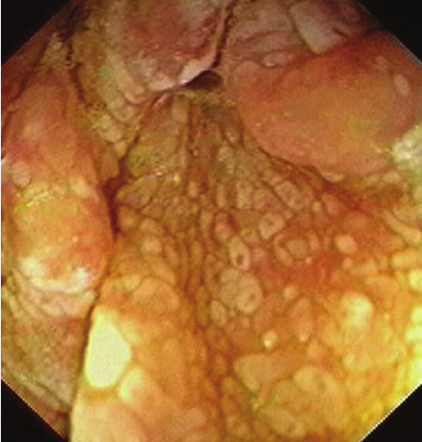
Figure 6: Whipple’s disease: endoscopic view of the proximal jejunum. Transverse folds are low, reduced, and swollen.